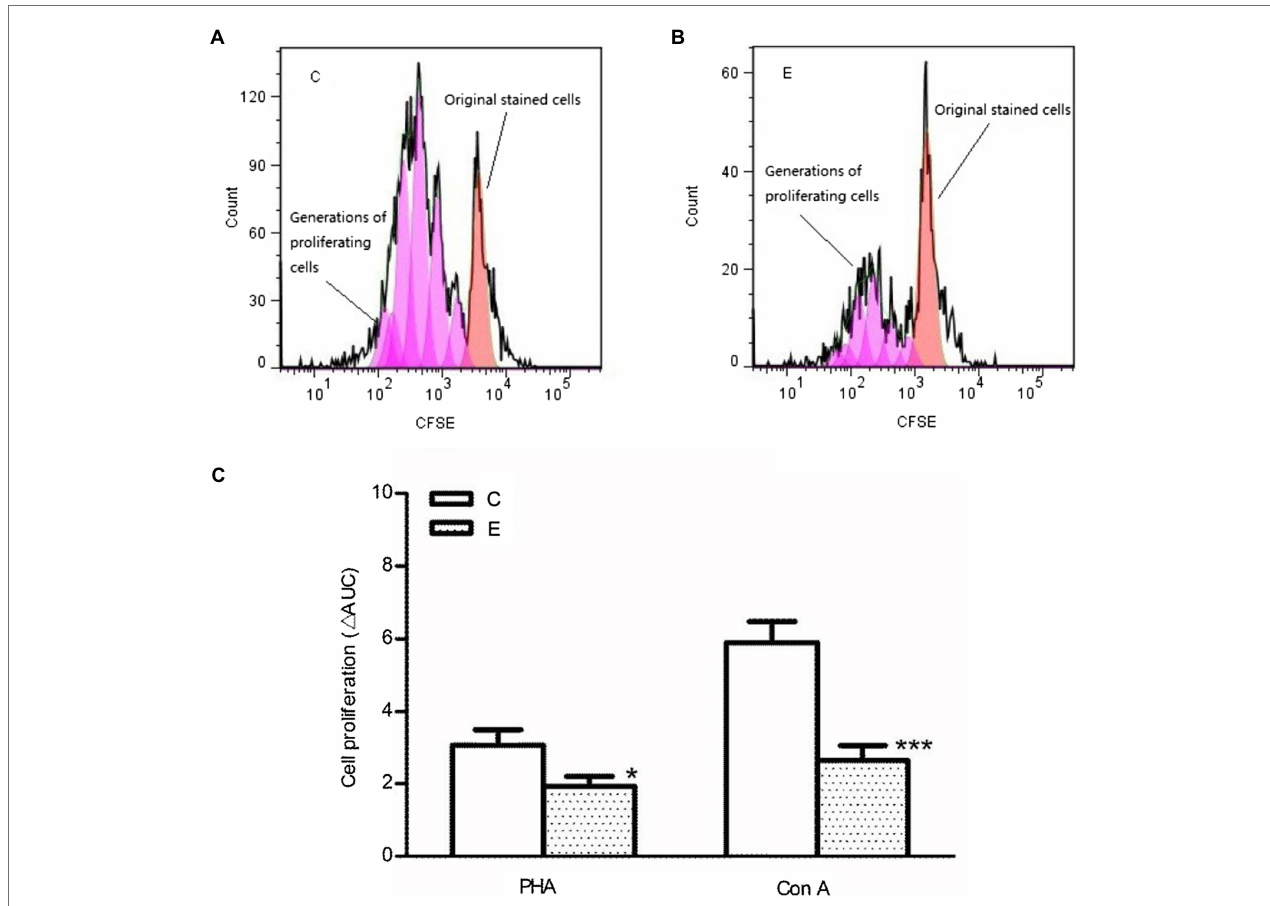
FIGURE 6 | Effects of acute exercise on proliferative capacity of lymphocytes. (A,B) CFSE proliferation profile; (C) statistical analysis of cell proliferation. E, the exercise mice, which were killed 3 h after exercise; C, the control group; Con A: concanavalin A; PHA: phytohemagglutinin. Data are presented as mean ± SEM, * p < 0.05, *** p < 0.001 vs. control ( n =